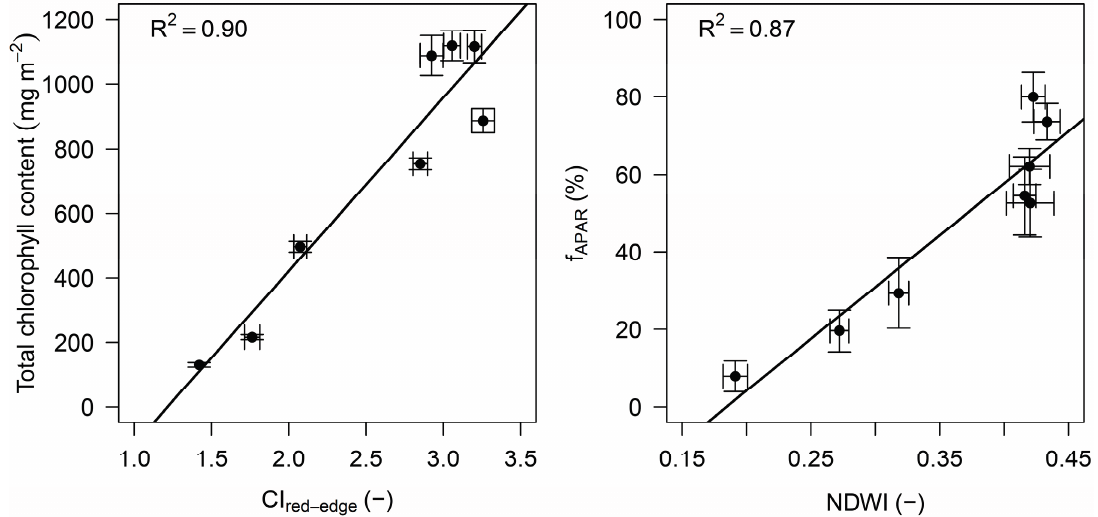
Figure 8. Left : Relationship between Red-Edge Chlorophyll Index—CI red-edge ( − ) and total chlorophyll content (mg m − 2 ); Right : Relationship between Normalized Difference Water Index—NDWI ( − ) and fraction of absorbed photosynthetically active radiation (f APAR ). Each CI red-edge and NDWI data point corresponds to a daily average calculated from reflectance data acquired between 10:00 a.m. and 1:00 p.m. R 2 —coefficient of determination ( − ), error bars represent standard